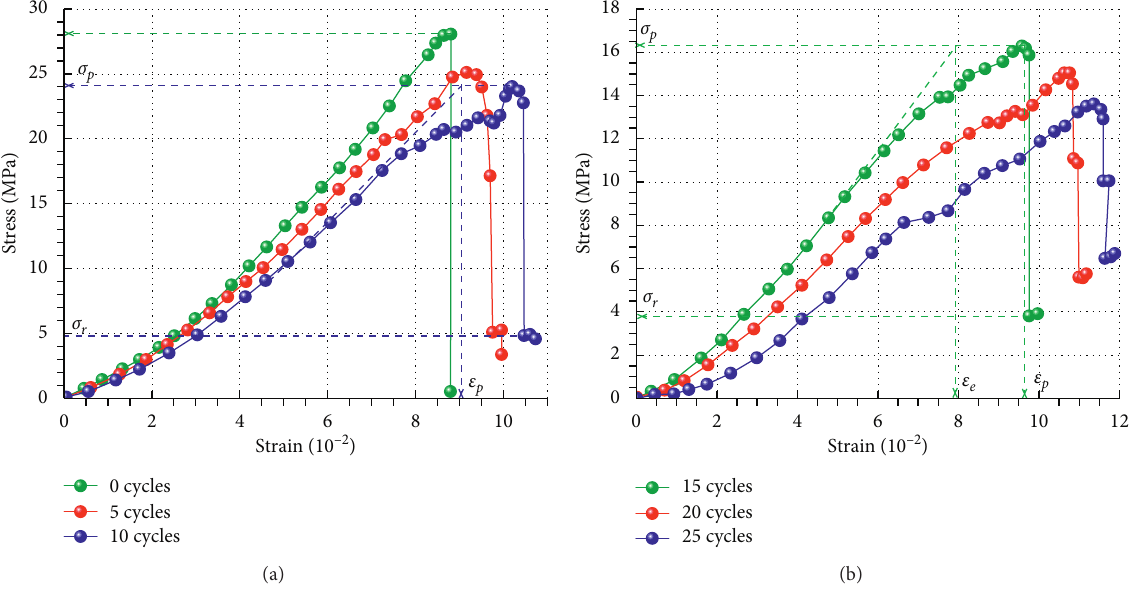
Figure 3: Stress-strain curves of the samples subjected to different freeze-thaw action.